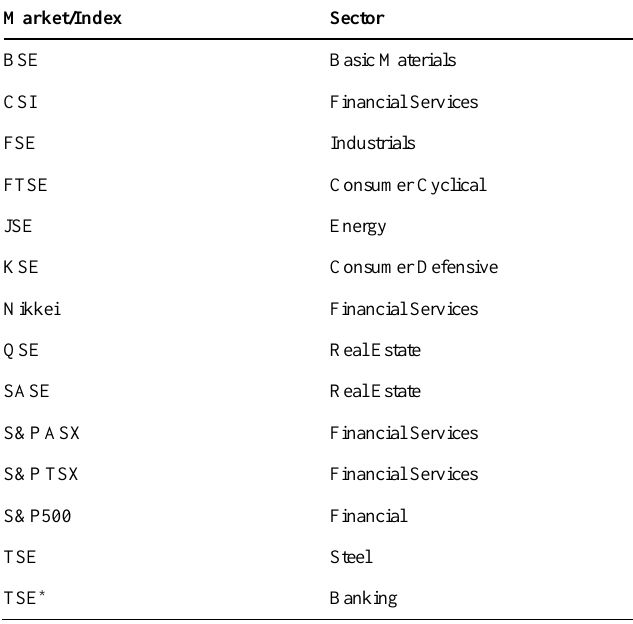
Table 18. The main information transmitter sectors, after COVID-19